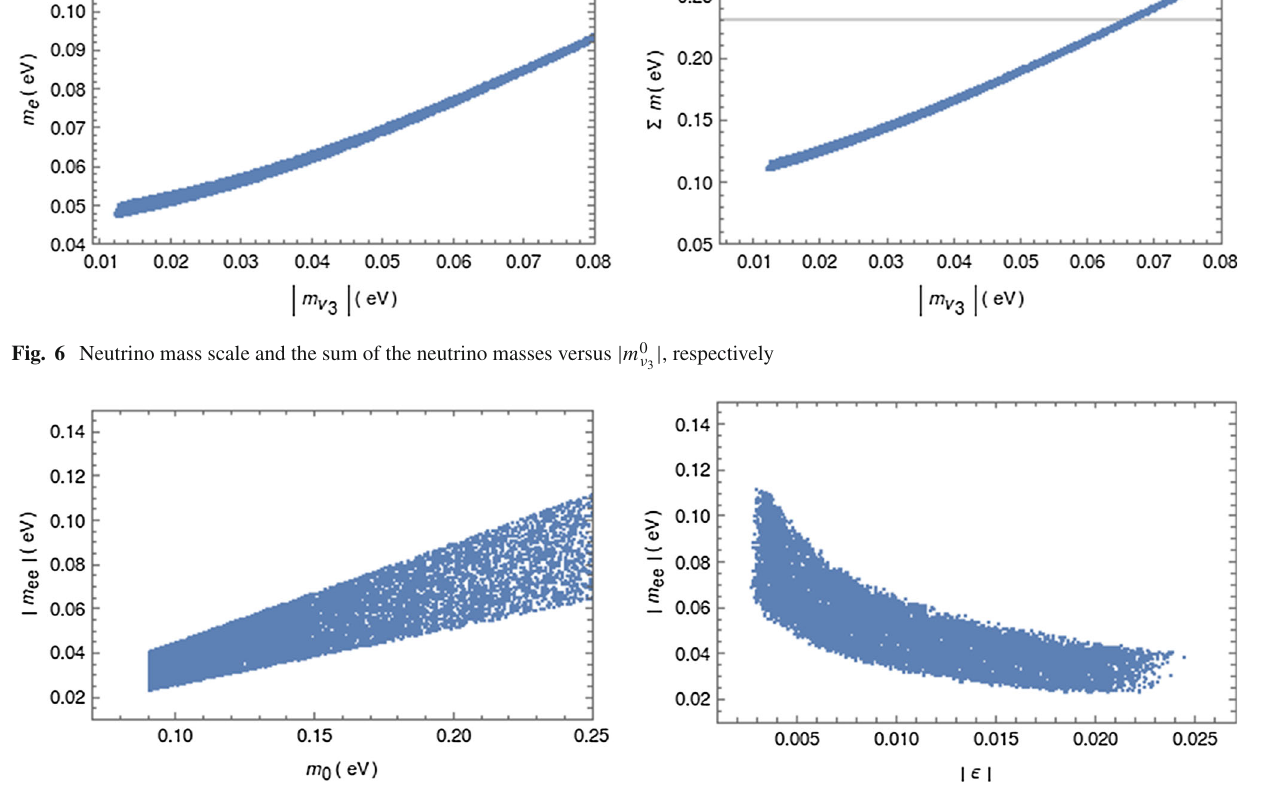
Fig. 7 | m ee | versus | m 0 | and | (cid:4) | , respectively Degenerate